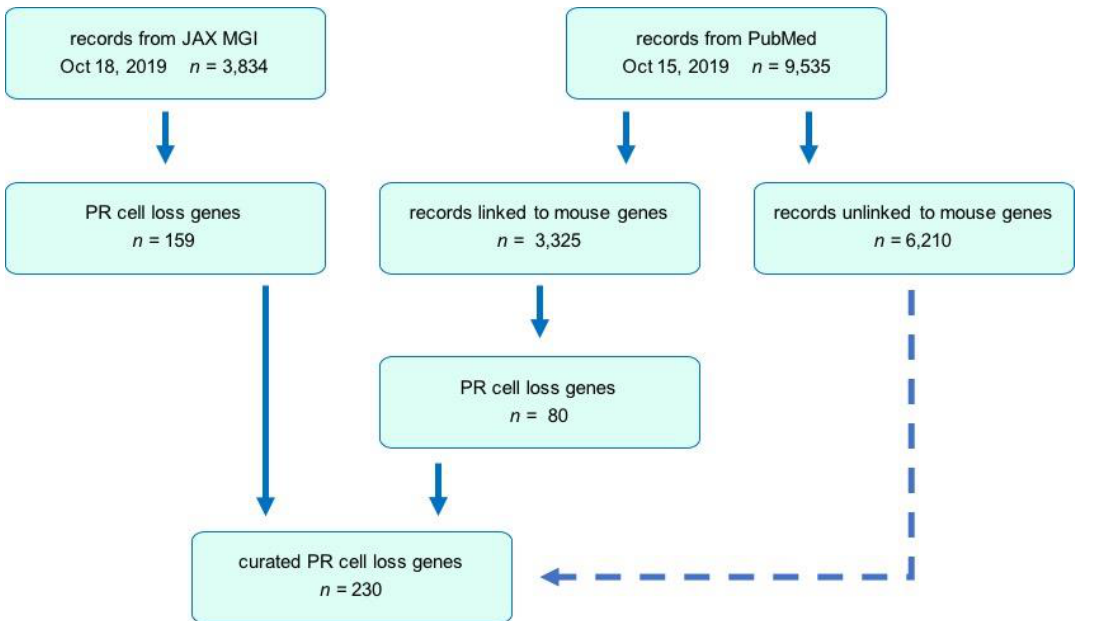
Figure 2. Flow chart depicting the progression of the search strategy utilized in this review. The number of records or genes identified from them is indicated at each stage of the process. The dashed line indicates that some genes were identified from records that remain to be systematically screened.